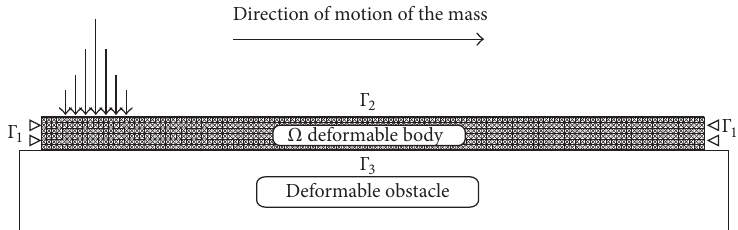
Figure 1: Reference configuration of the two-dimensional